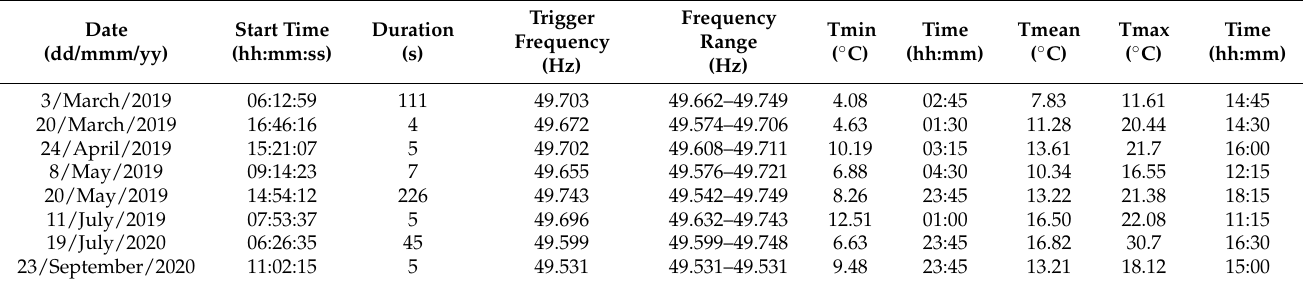
Table 3. Overview of grid frequency events occurring in 2019 and 2020 during the AHU operating hours and the external temperature collected from the case study site on these days. Date